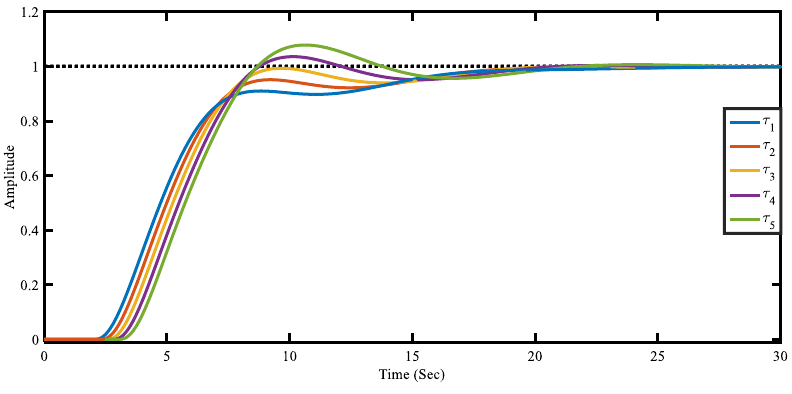
Figure 5. Proposed LFC system sensitivity to delay. Table 2. The maximum permitted delay for an EV aggregator with α 1 = 0.2 and τ M